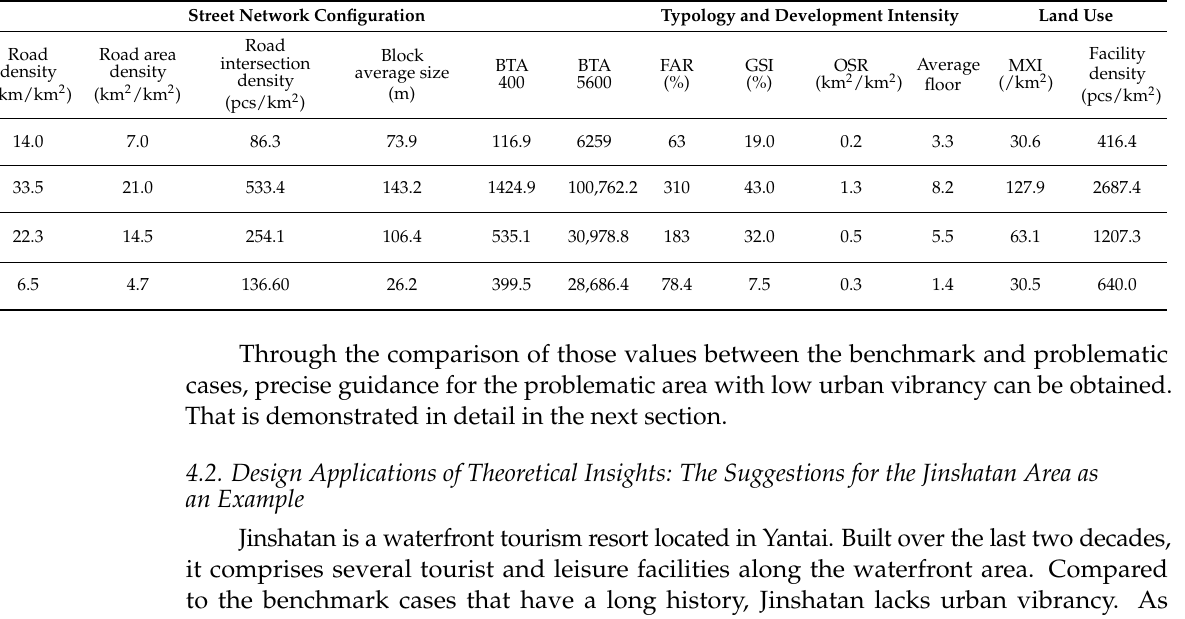
Figure 16. The distribution of MXI in the successful coastal cases. Table 3. Quantitative analysis